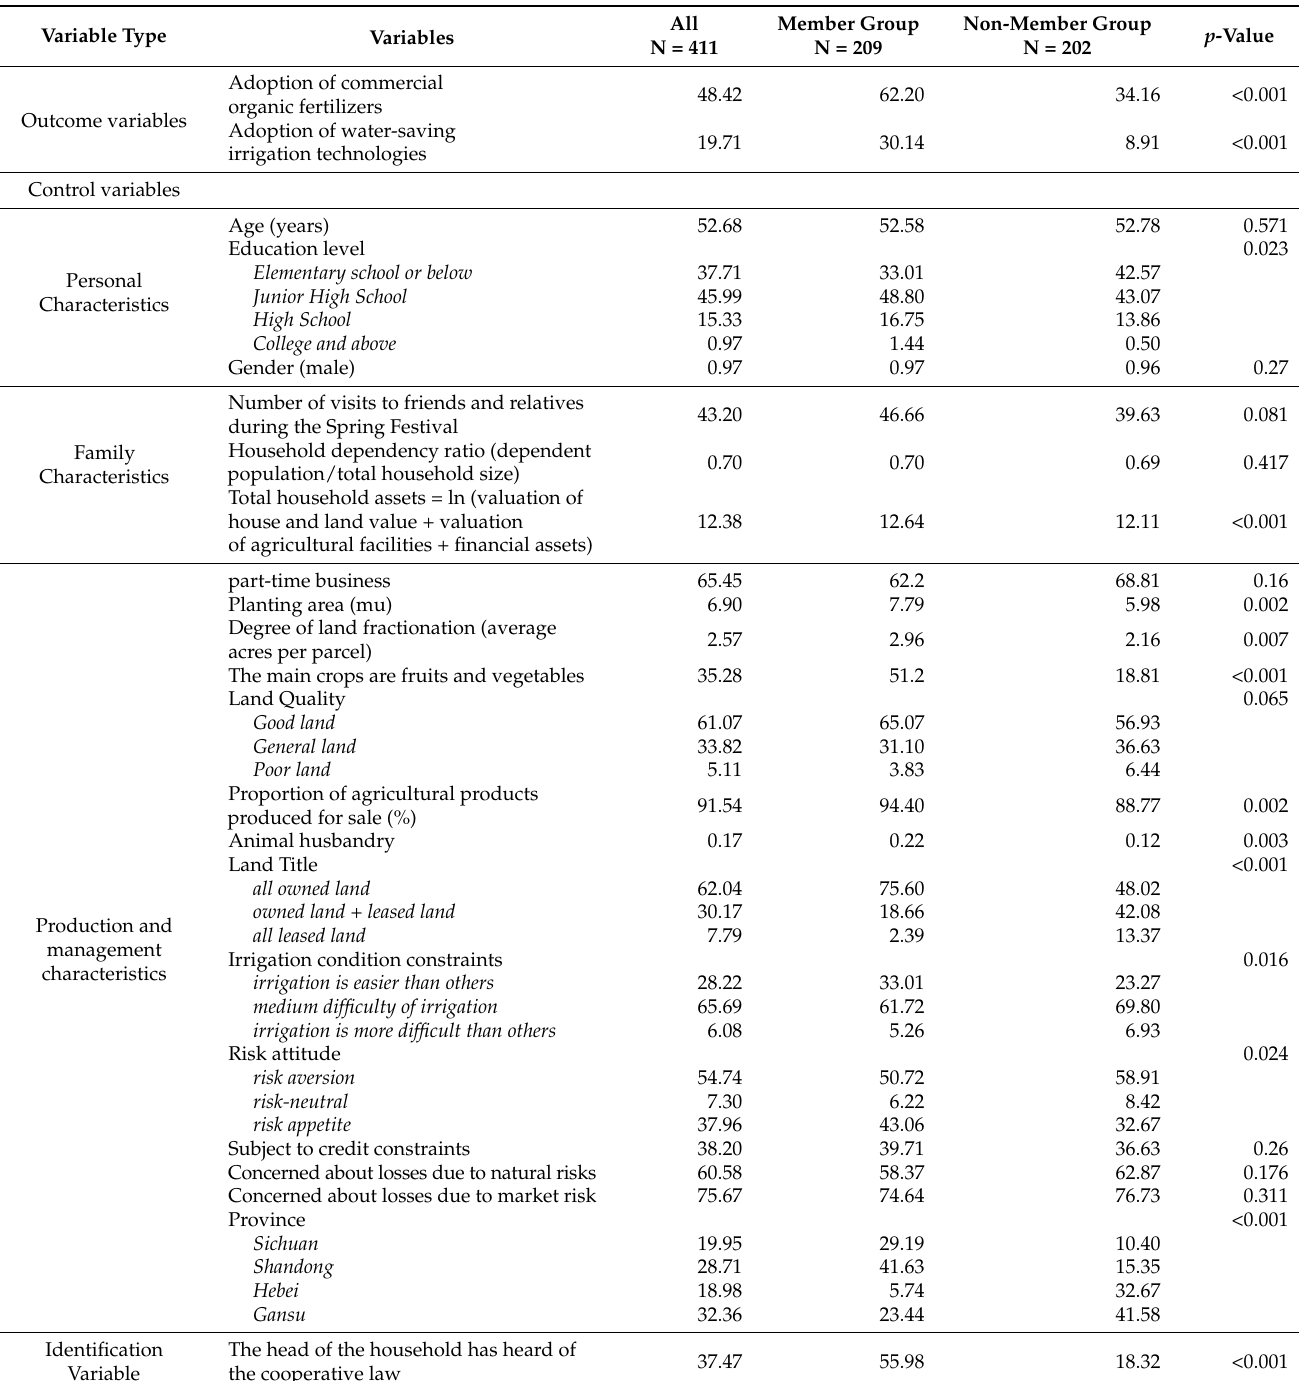
Table 2. Descriptive statistics of the main